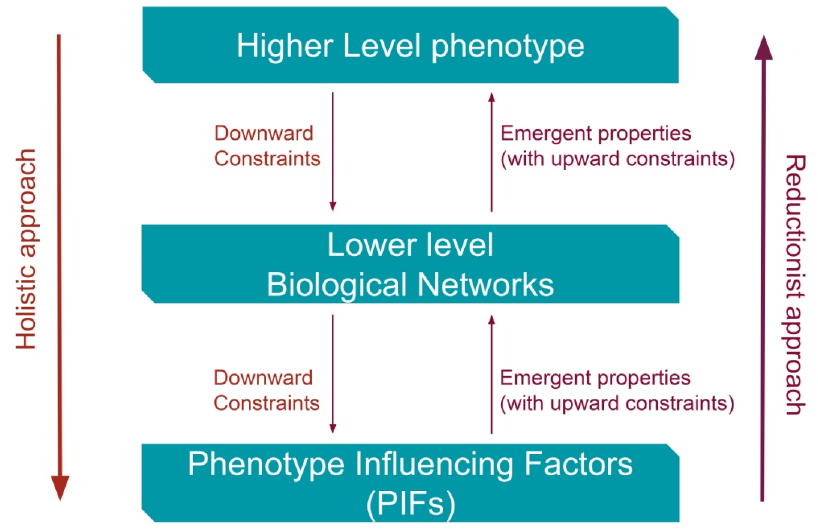
Figure 1. Constraints and emergent properties: two concepts of systems biology (SB) explaining the interrelationship and interaction between higher and lower levels of the biological ladder. PIFs = Phenotype Influencing Factors (comorbidities, diseases’ compensatory–regulatory mechanisms (DCRM), environmental factors and deoxyribonucleic acid (DNA) sequences).